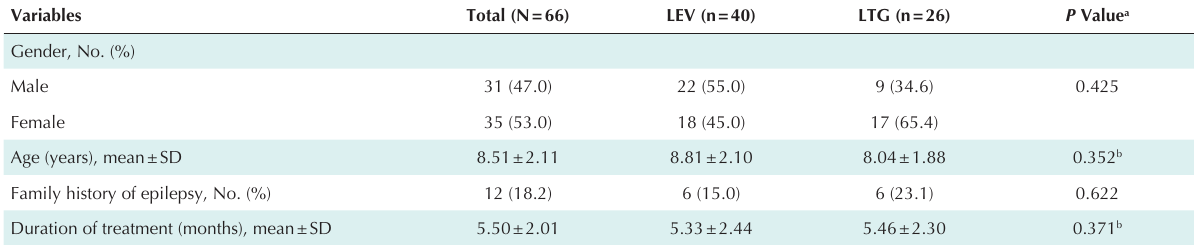
Table 1. General Characteristics of the Study Population